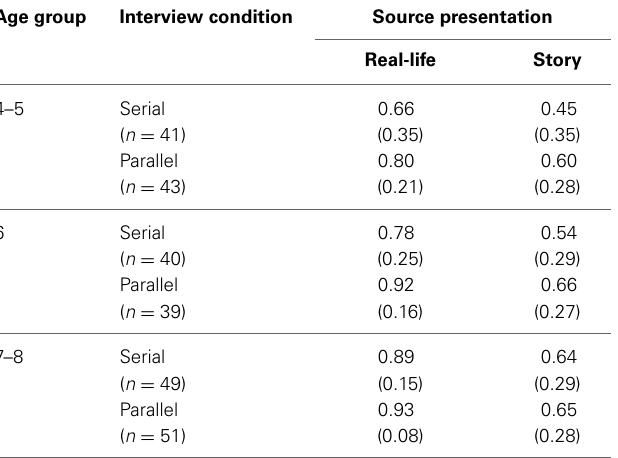
Table 3 | Mean source accuracy proportions by age, interview condition and source presentation.